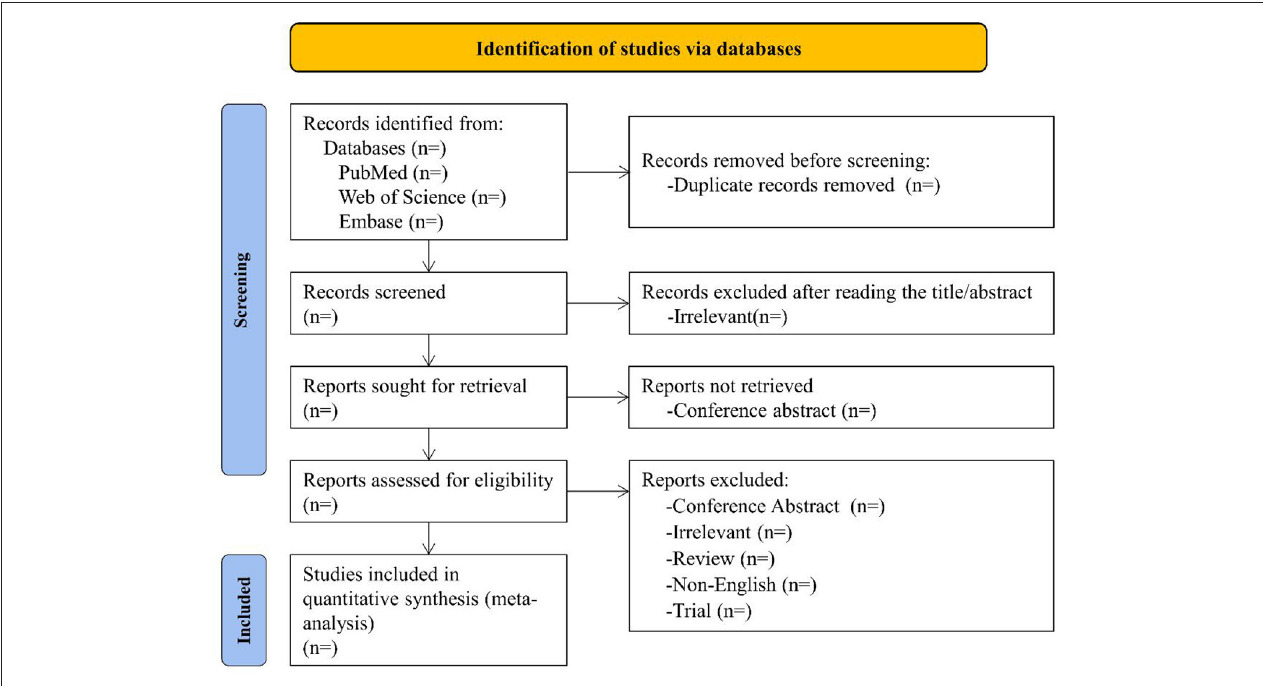
FIGURE 1 | Flowchart showing the results of the selection process.